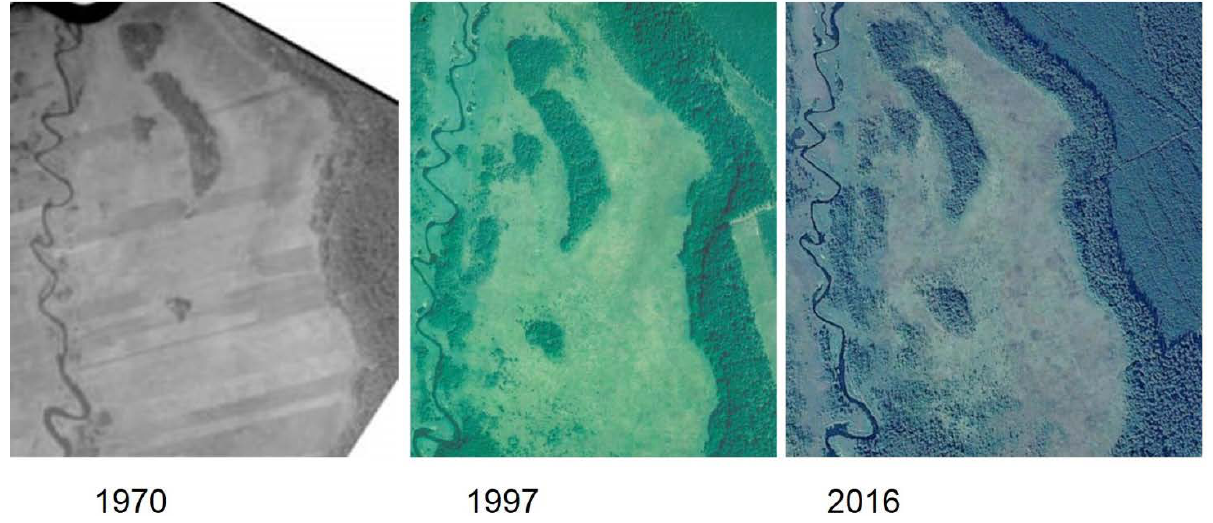
Figure 1. Aerial photographs of the southern basin of the Rospuda mire in 1970, 1997 (images obtained from Geodesic and Cartographic Documentation Center, PL) and 2016 (image source: Google Earth,